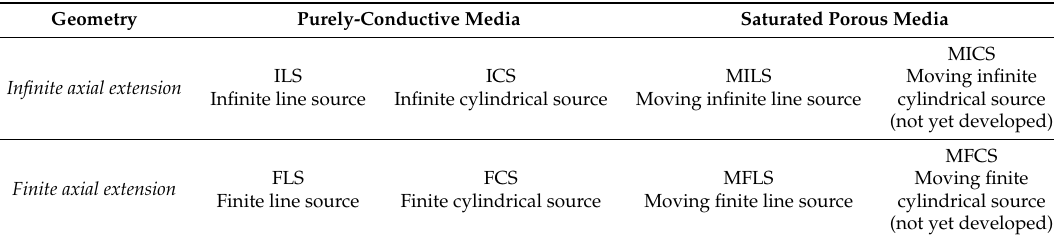
Table 1. Classification scheme and acronyms for analytical ground heat transfer models in